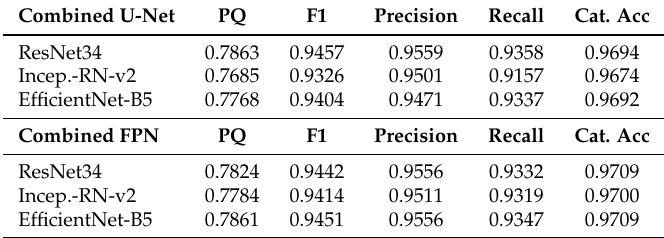
Table 7. Results of the ablation study with the combined segmentation on the test data set: For this evaluation, a reduced image resolution of 320 × 256 pixels was used. The results highlight the marginal impact of the different architecture choices (U-Net vs. Feature Pyramid Network (FPN)) as well as the different